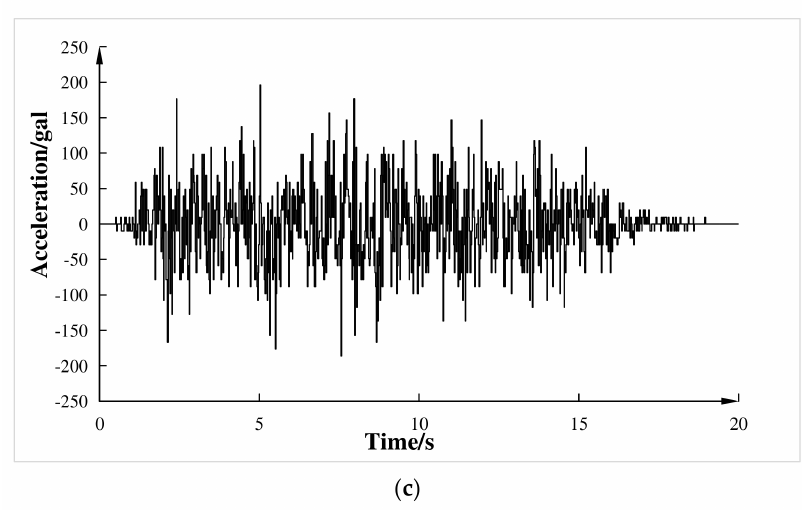
Figure 6. Seismic waveform. ( a ) El Centro Wave; ( b ) Taft Wave; ( c ) Lanzhou Artificial Wave.